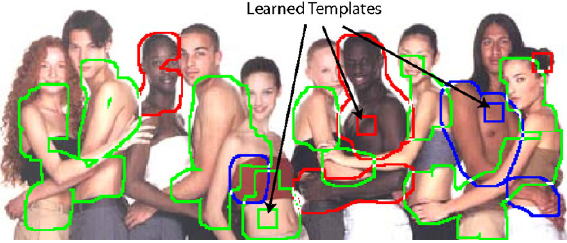
Figure 17: Skin tone identification revisited (using the processing core of the chip). The unimodal Hue distribution of skin leads to some